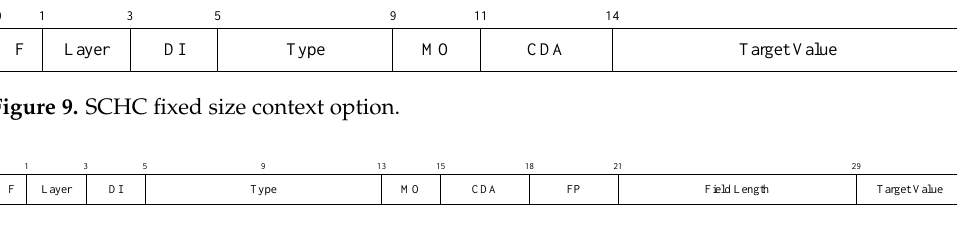
Figure 10. SCHC variable size context